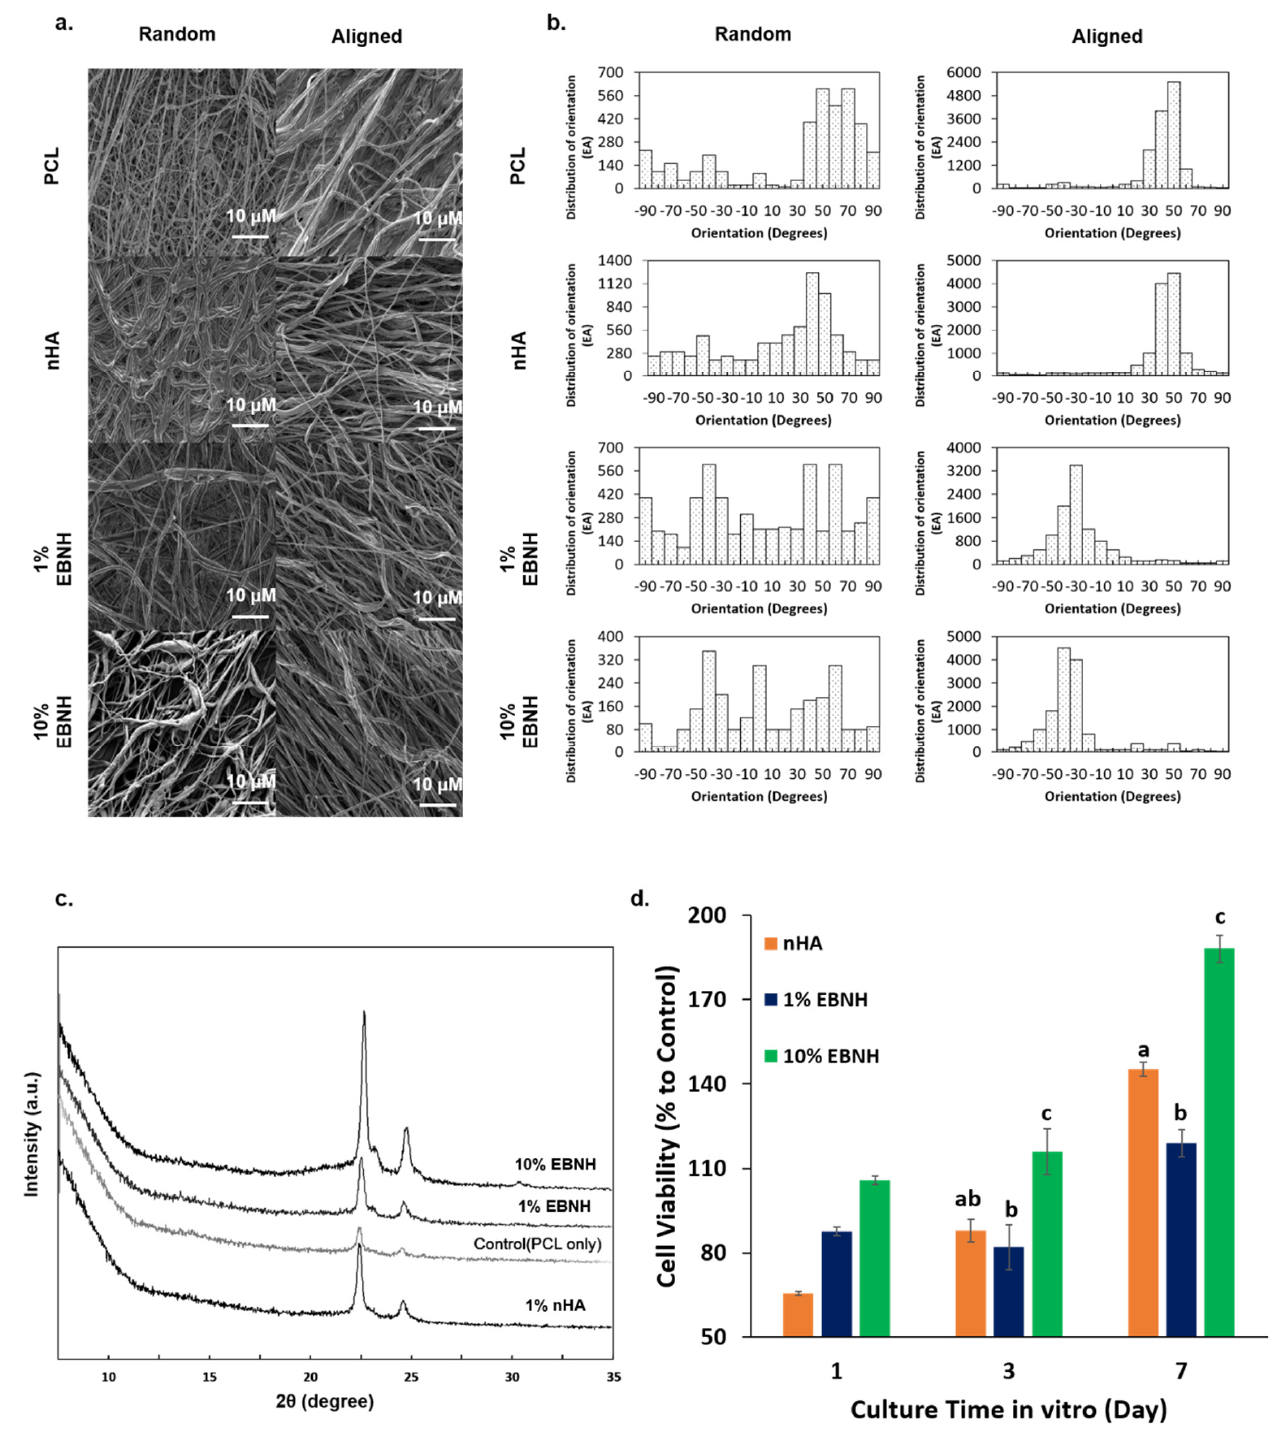
Figure 2. Characteristics of EBNH-RBs. ( a ) FESEM images of the fiber. ( b ) Distribution of fiber alignment. Aligned EBNH-RBs showed at least 3000 to 4000 distributions in certain alignments compared to random EBNH-RBs. ( c ) XRD peaks of electrospun nanofibers. ( d ) WST-1 results of cells cultured on EBNH-RBs by day. EBNH-RBs maintained the peaks of EBNH or hydroxyapatite after electrospinning, and viability increased by almost two-fold in the day 7 10% EBNH group. (Having non-identical letters, such as a and b, means that the groups have statistically significant differences at p < 0.05 ( n = 5).